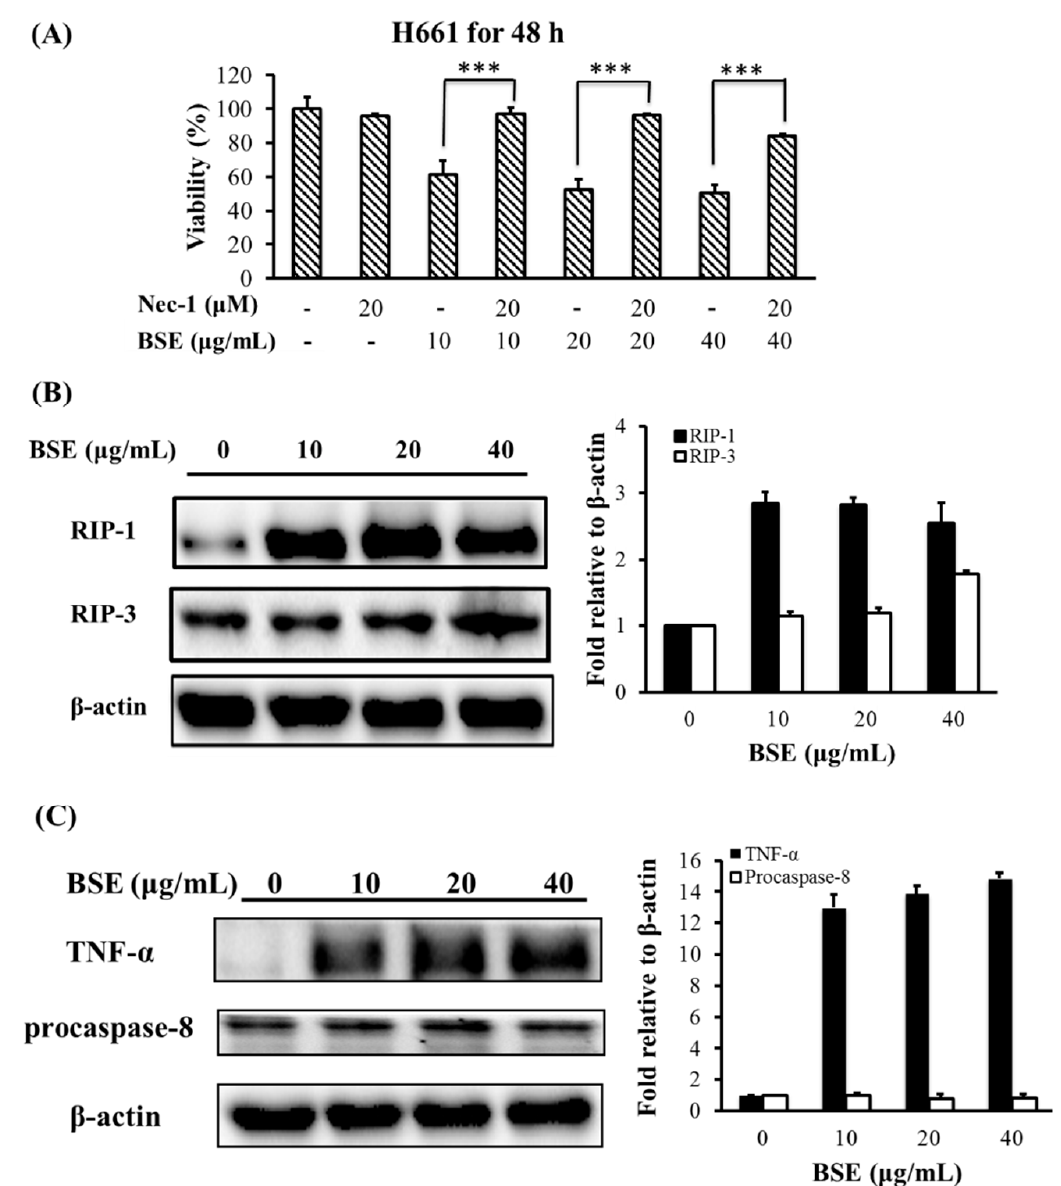
Figure 5. BSE induces cell death via necroptotic pathway in the H661 cells. ( A ) Cytotoxic effect of BSE is reverted by Nec-1. H661 cells were pretreated with or without 20 µ M nec-1 for 30 min and then treated with different doses of BSE (10, 20 and 40 µ g/mL) or DMSO (0 µ g/mL) for 48 h. The viability of these cells was measured by MTT assay. A significant difference between the denoted two experiments was indicated as *** p < 0.001. ( B ) BSE induces RIP-1 expression in H661 cells; ( C ) BSE induces TNF- α expression in the absence of caspase-8 activity in H661 cells. Cell extracts from BSE administration were harvested at 24 h and subjected to western blot analysis. Densitometric analyses of protein were normalized to the loading control β